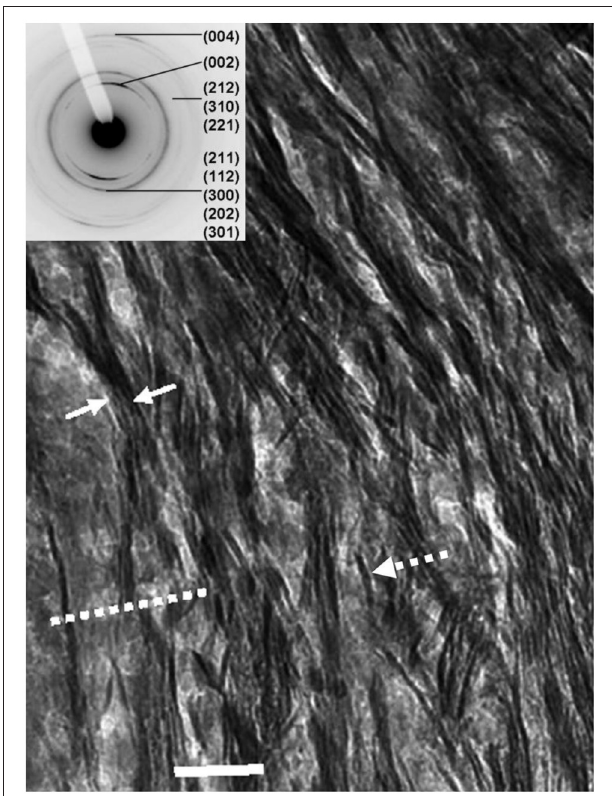
FIGURE 2 | Longitudinal view of human femur: dashed arrow, single mineral lamella viewed edgewise; solid arrows enclose a stack of mineral lamellae; dashed line shows trace of a mineralized gap zone; scale = 50 nm. Inset: SAED (selected-area electron-diffraction) pattern from this section indexed for the apatite Bragg reflections; note that 002 reflection is in form of two arcs, showing partial preferred orientation of c-axes of apatite crystals parallel to the long-axis of bone.